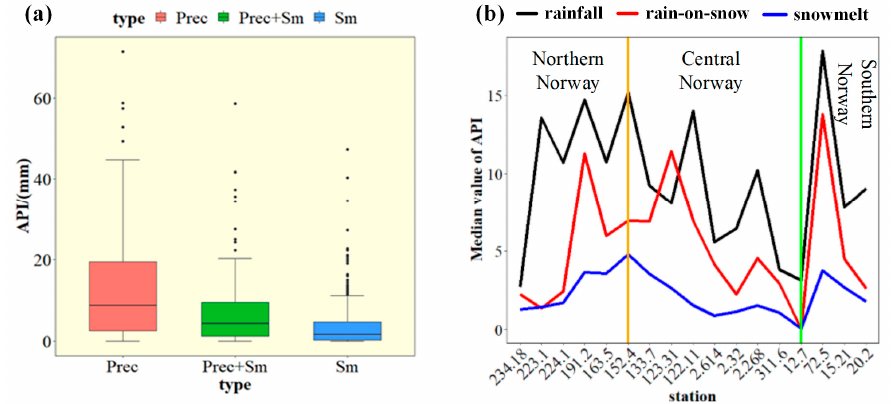
Figure 7. Relationship between API median and identified flood types. ( a ) box-plot of the API for different FGMs averaged by all stations; ( b ) relationship between API median and its geographical location for each FGM.